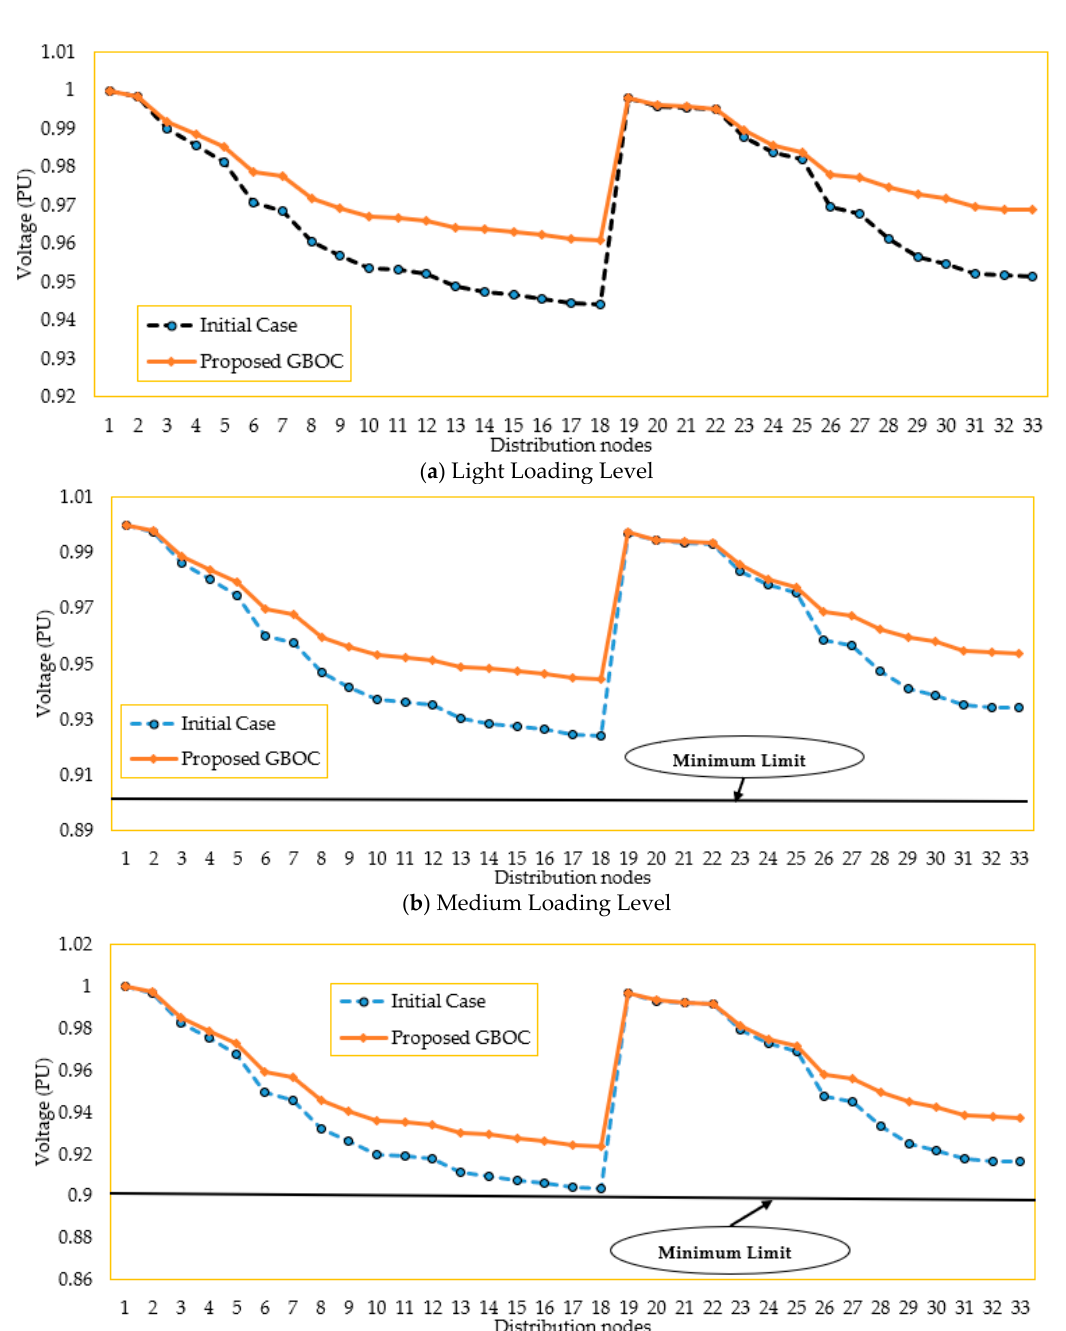
Figure 6. Voltage profile for the IEEE 33-distribution system based on the proposed GBOC versus the initial case.